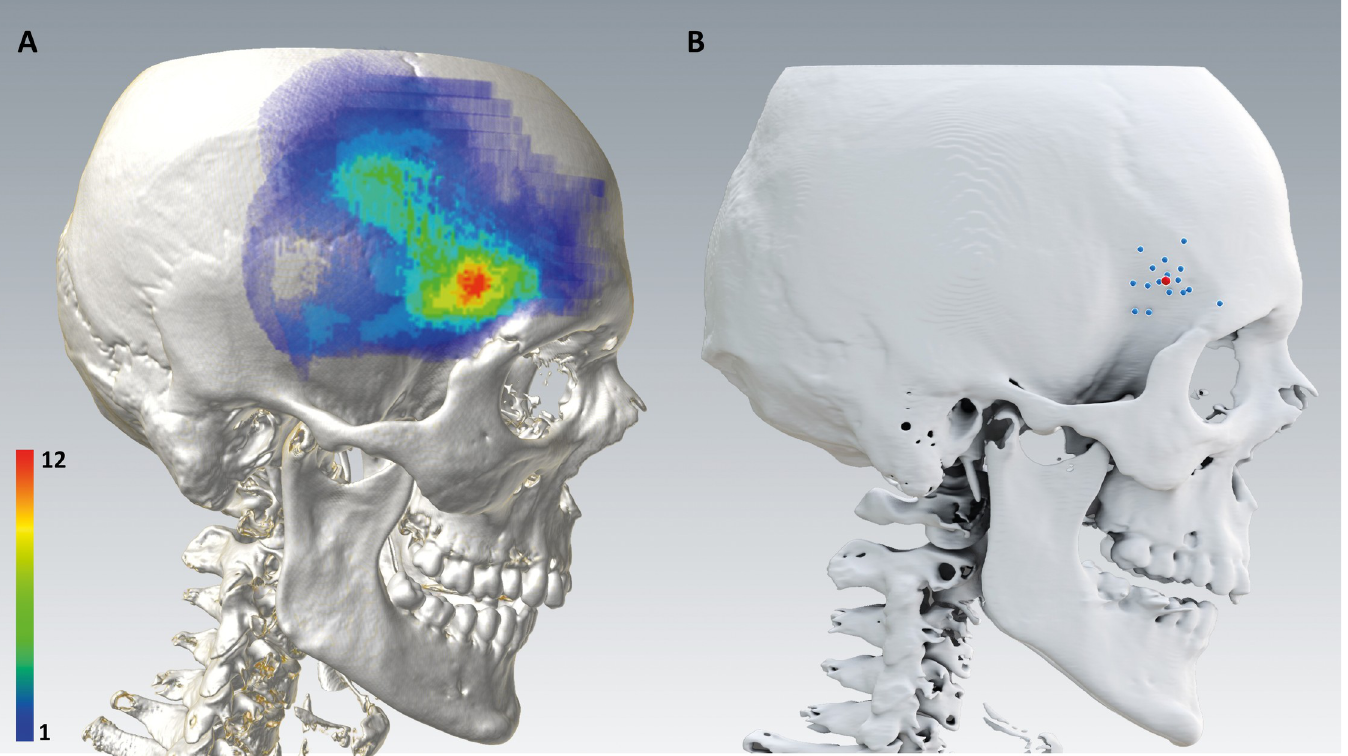
Fig 3. Matching of all 16 cases harbouring an apparent hollowing defect to one head of reference. A: Heat map depicting the areas with high intersections between the individual defects (blue: 1 case, red: 12 cases, total: 16 cases) B: Localisations of the deepest point of each single defect (blue) and their mean position (red) projected onto the skull bone from a lateral point of